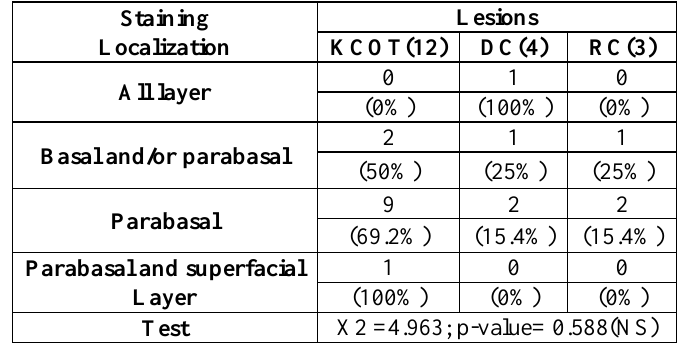
Table 6: Cyclin D1 Score Distribution in the Connective Tissue Capsule of KCOT, DC and RC